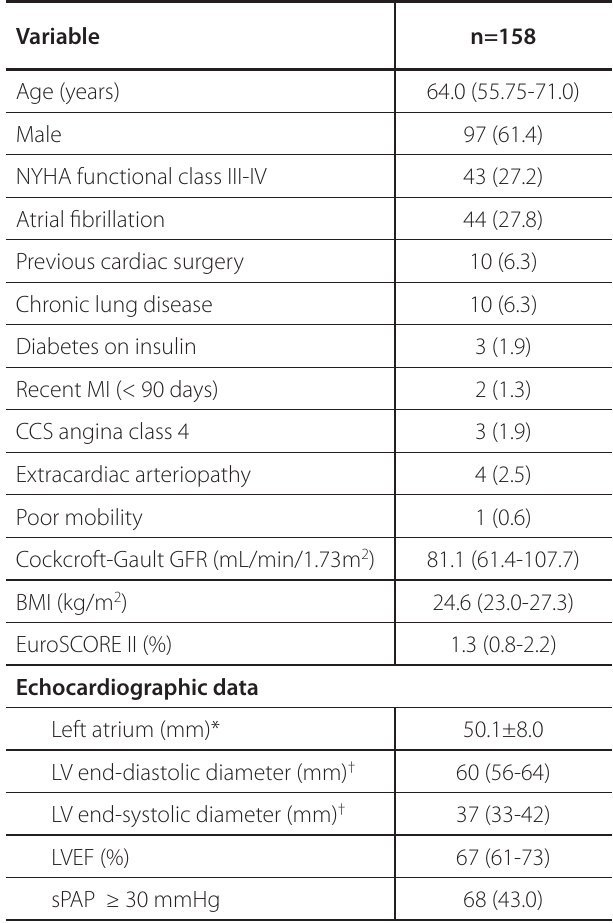
Table 1 . Patients’ baseline